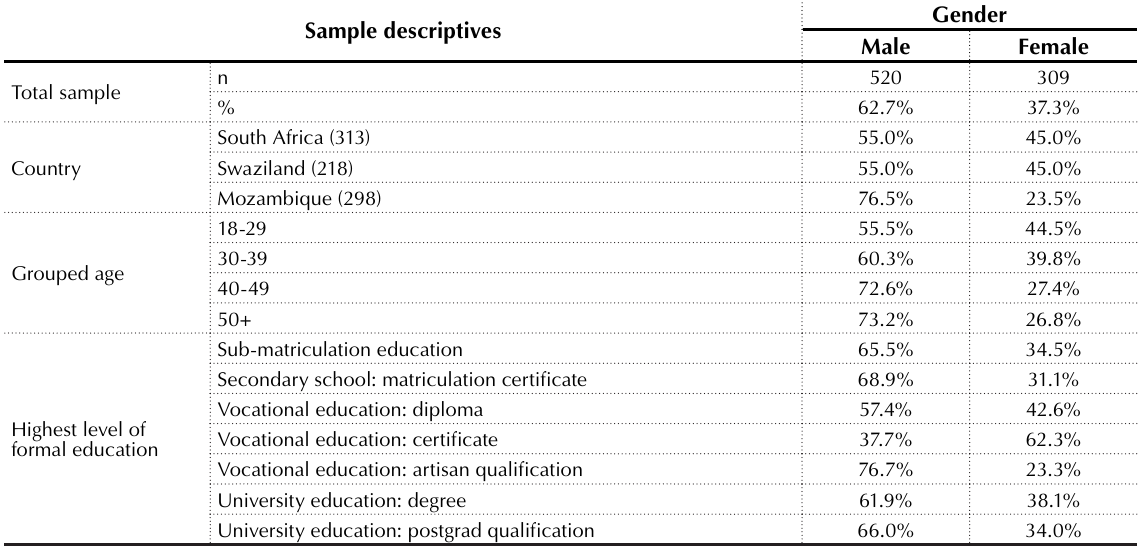
Table 1. Gender profile of respondents Sample